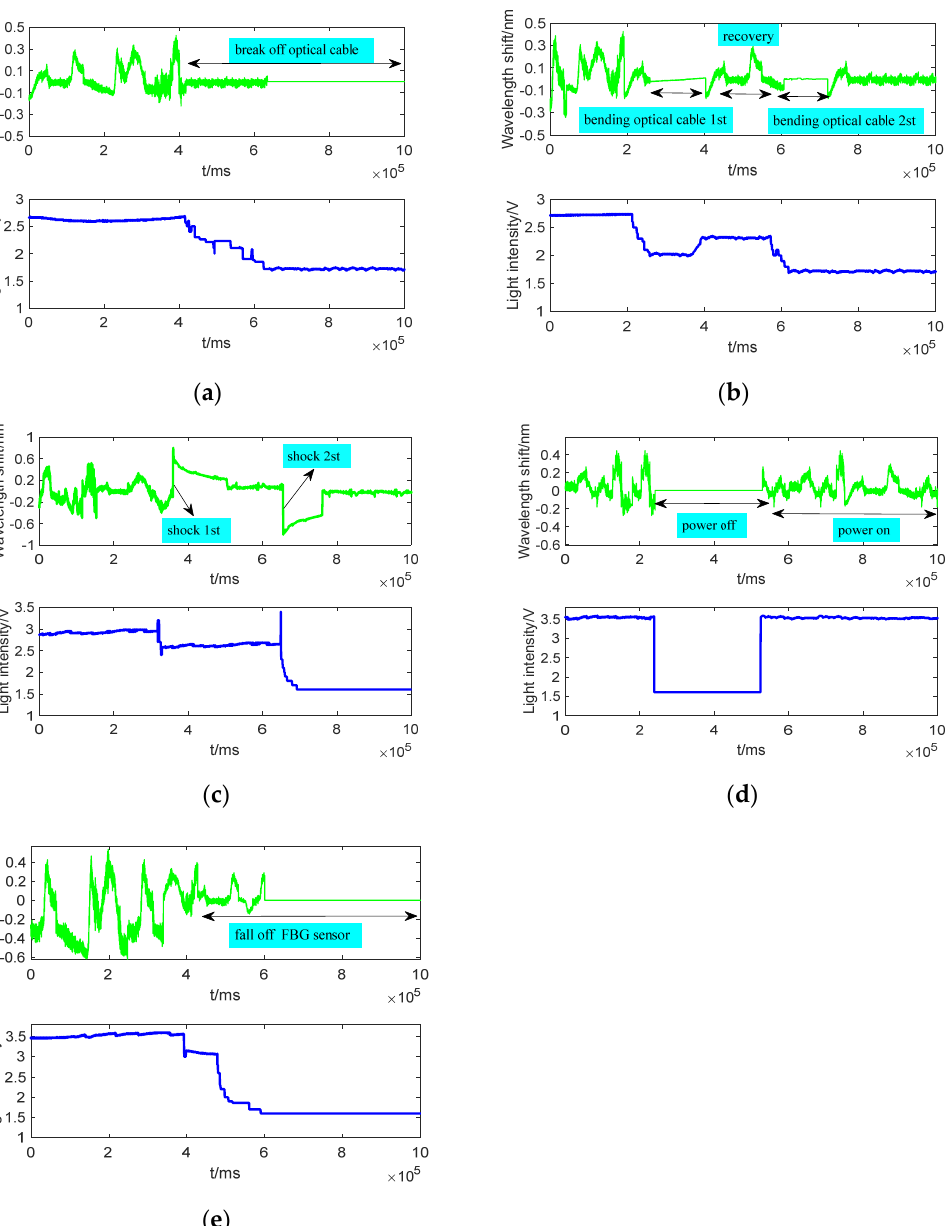
Figure 7. Simulation setup of typical faults on FBG sensors.